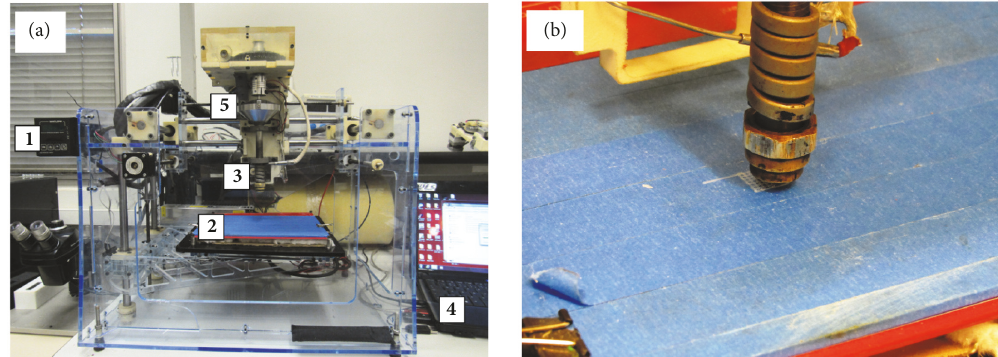
Figure 1: (a) Fab@CTI 3D printer, where 1: speed and temperature controller; 2: printing platform; 3: extrusion mini-screw head; 4: control computer; and 5: feed hopper. (b) Construction of the first layer under a 0 ∘ /90 ∘ deposition